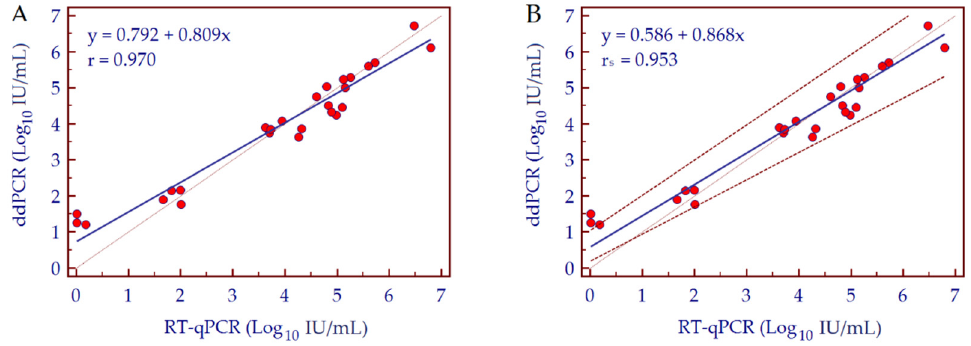
Figure 6. Regression analysis of HDV-RNA concentration values of clinical specimens obtained from HDV-infected patients, quantified by both RT-qPCR and ddPCR. ( A ) Deming regression analysis and ( B ) Passing and Bablok regression analysis.